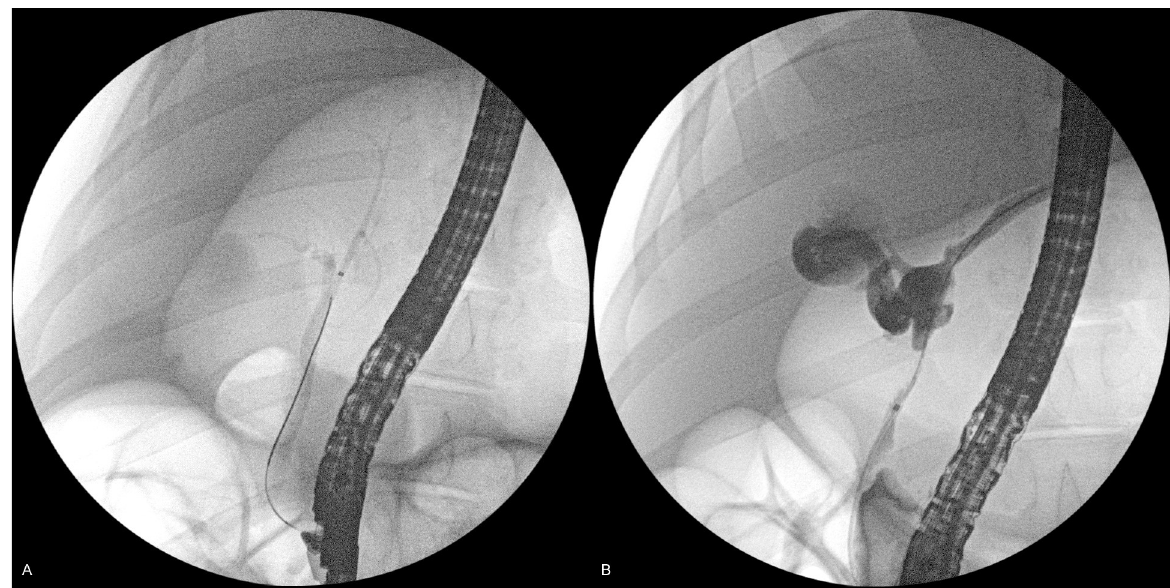
Fig 2. Endoscopic retrograde cholangiography images obtained before ( A ) and 35 days after ( B ) ethanol ablation. Stricture formation is observed at the ablated site, and dilation of the intrahepatic bile duct is observed 35 days after ablation.